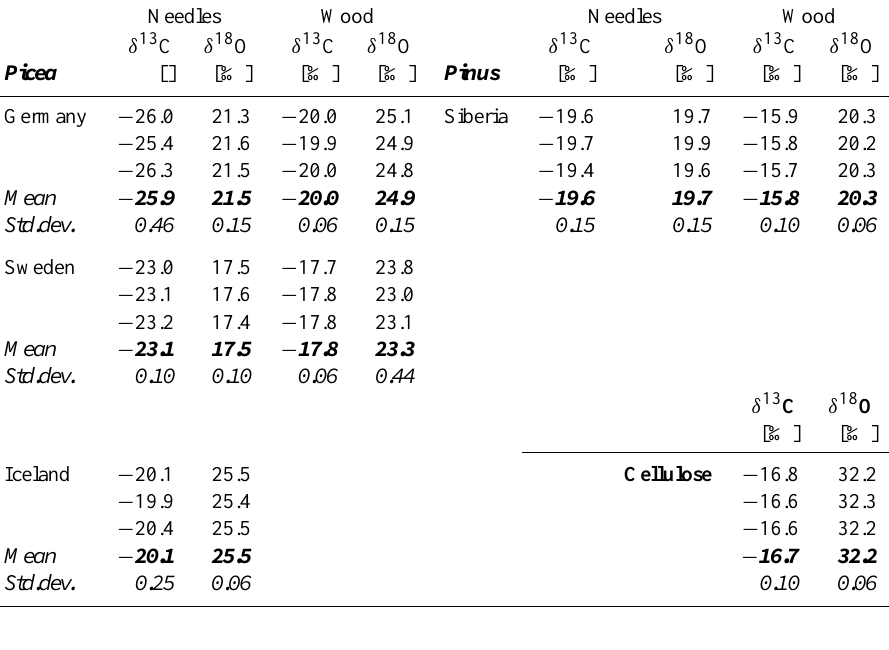
Table 2. Isotopic values of needles and wood from singular trees grown in central Germany (Gifhorn), northern Sweden (Ume˚a), central Siberia (Zotino) and Iceland (M´yvatn) and of cellulose reference material ( δ 13 C is given on the VPDB scale, δ 18 O on the VSMOW scale).